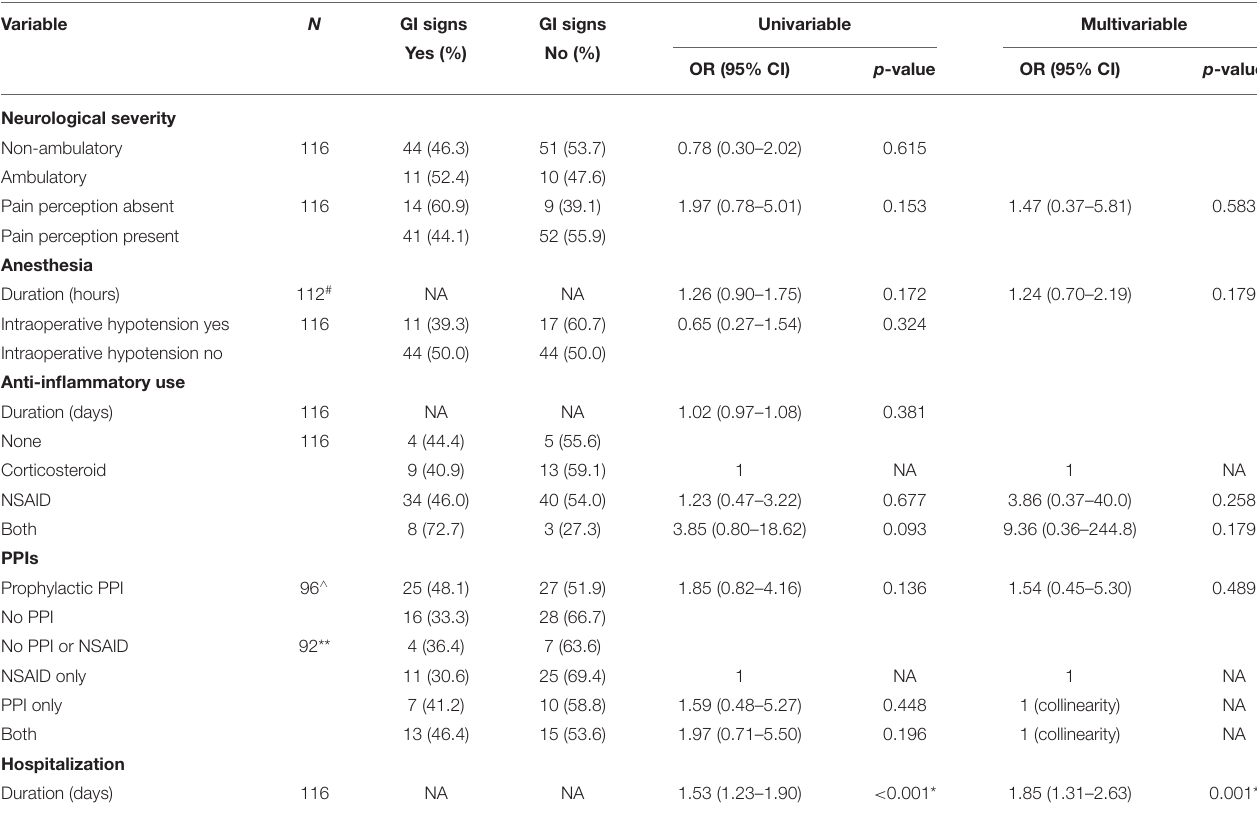
TABLE 5 | Univariable and multivariable analysis of risks factors for the development of GI signs in 116 dogs undergoing surgery for TL-IVDE. Variable N GI signs GI signs Univariable Multivariable Yes (%) OR (95% CI) p